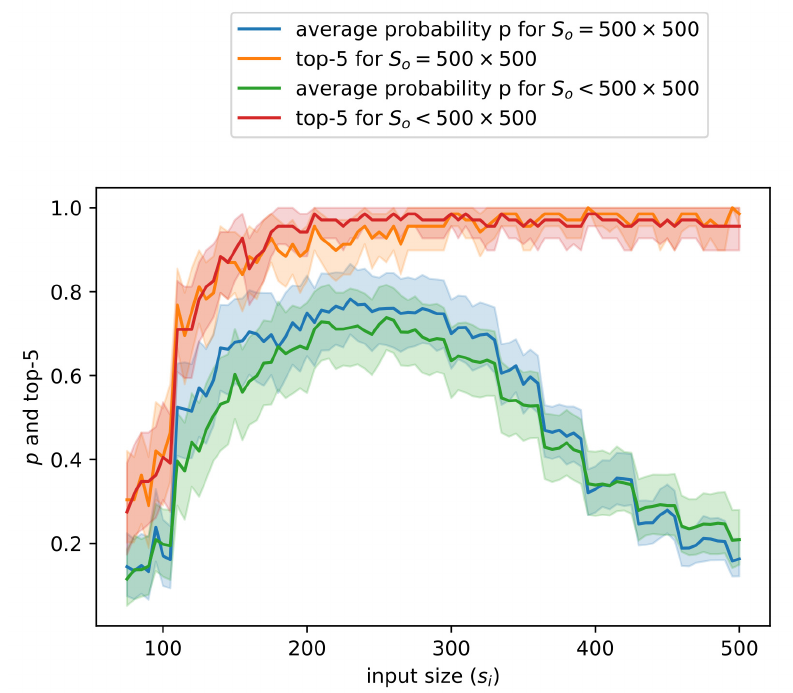
Figure 6. Average probability p of correct class and top-5 accuracy vs. input size s i for 69 filled images with S o = 500 × 500 and 69 filled images with S o < 500 × 500 ( ¯ S o = 285 × 285). The 95% confidence intervals are